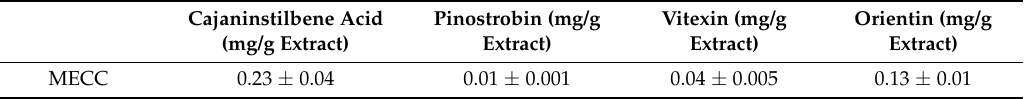
Table 1. Measurement of the main bioactive components in MECC.